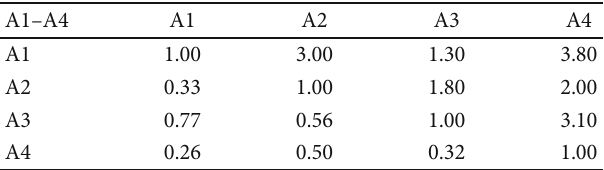
Table 8: First layer attribute judgment matrix.